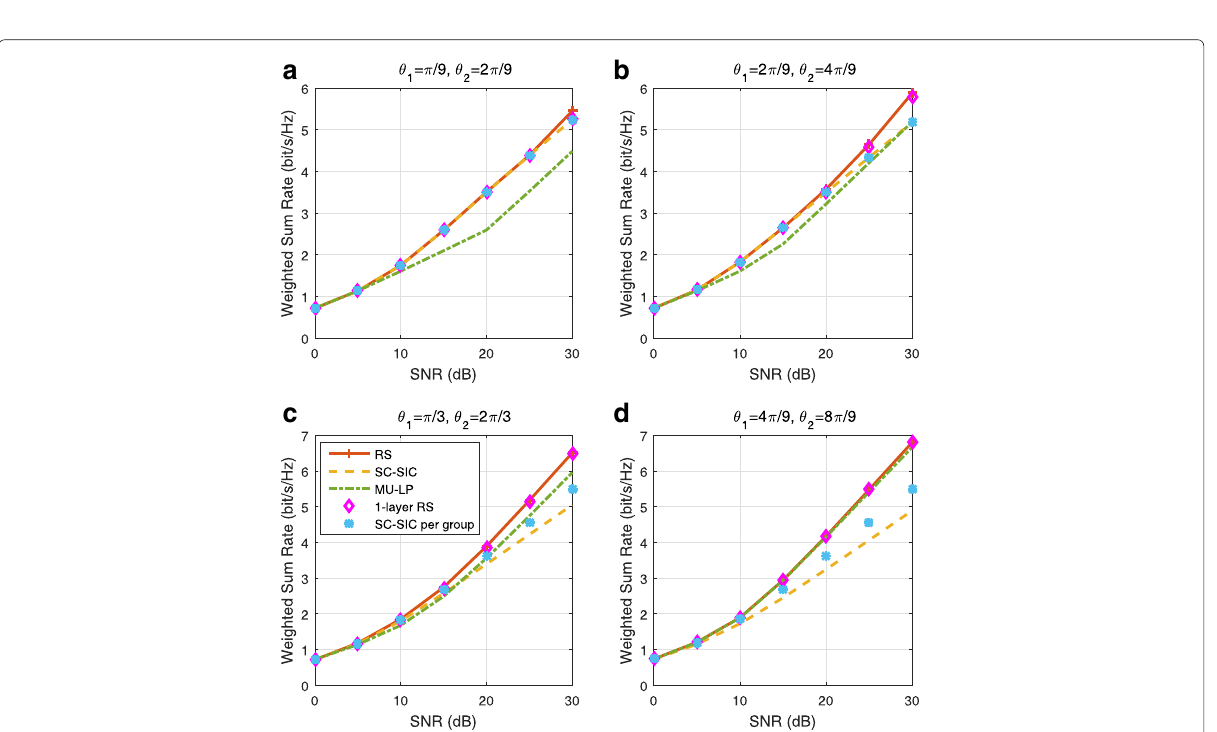
Fig.49 WeightedsumrateversusSNRcomparisonofdifferentstrategiesforunderloadedthree-userdeploymentwithimperfectCSIT, γ 1 = 1, γ 2 =